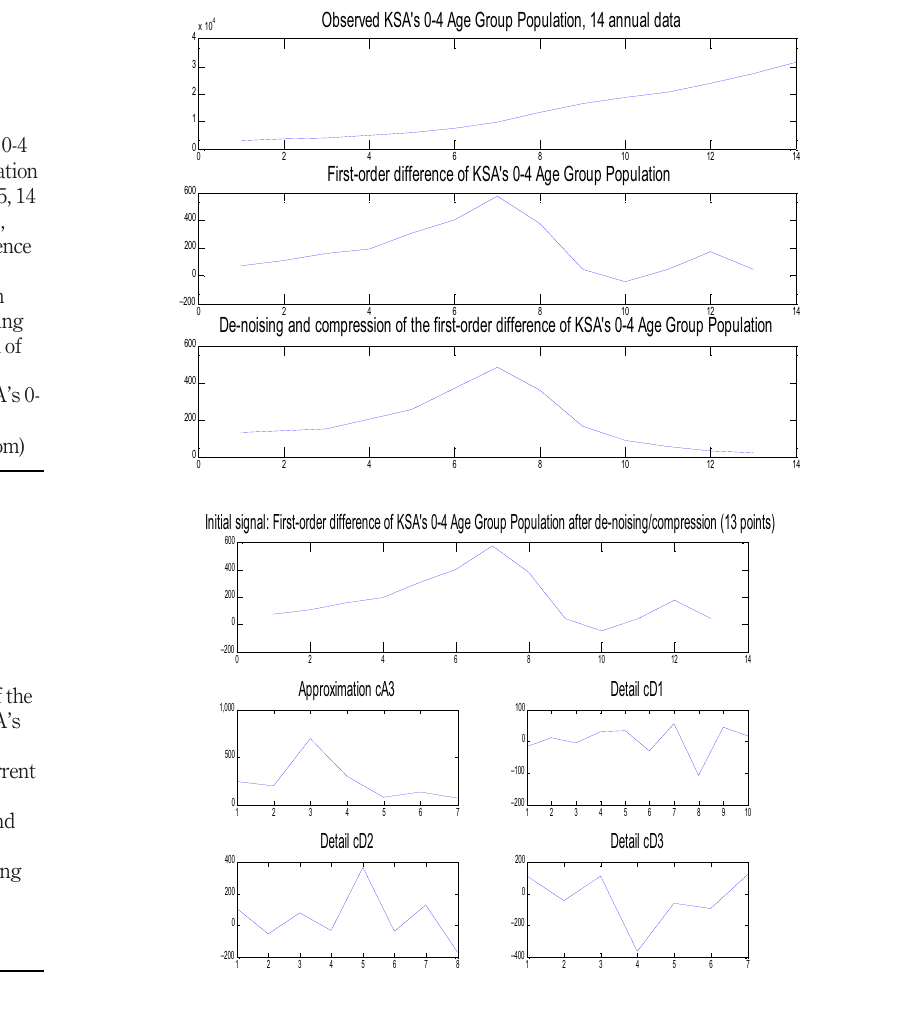
Figure 3. Observed KSA ’ s 0-4 age group population from 1950 to 2015, 14 annual data (top), fi rst-order difference of KSA ’ s 0-4 age group population (middle), de-noising and compression of the fi rst-order difference of KSA ’ s 0-